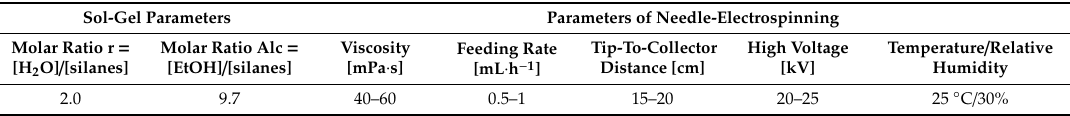
Table 1. Sols tested in electrospinning and conditions employed for the jet needle-electrospinning. Sol-Gel Parameters Parameters of Needle-Electrospinning Molar Ratio r = [H 2 O] /